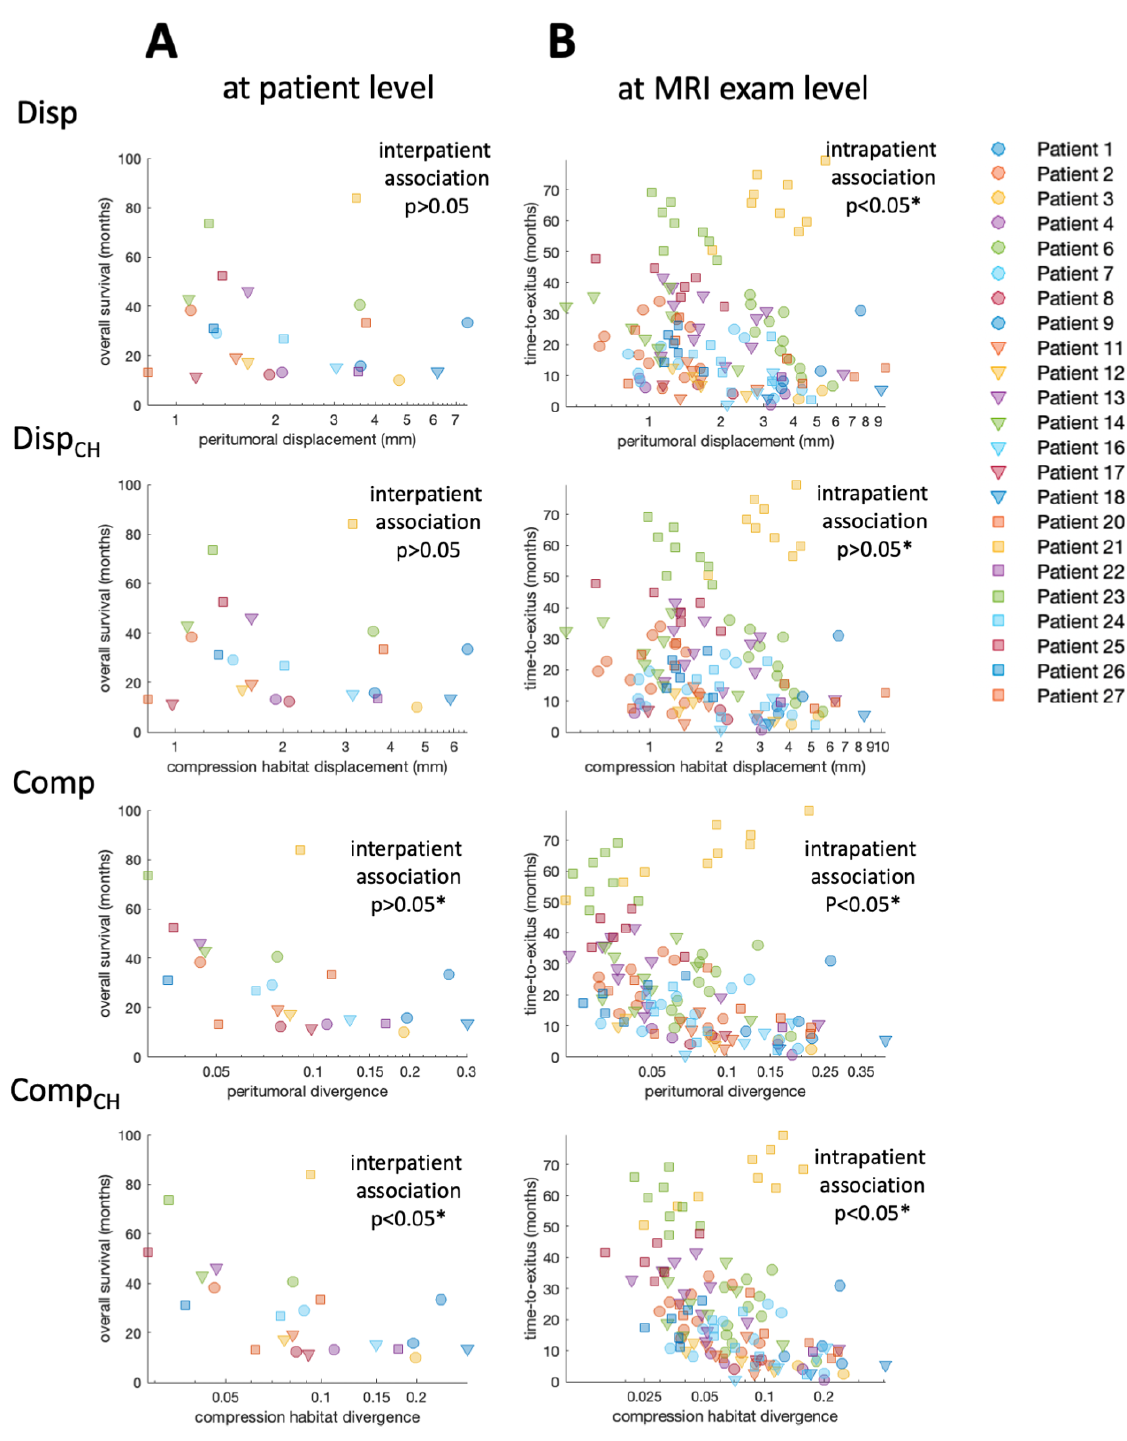
Figure 3. ( A ) Scatter plot showing the relation between median biomarker for each patient and overall survival. ( B ) Scatter plot showing the relation between biomarker for each MRI study and time-to-exitus. Each combination of marker color and shape corresponds to a different patient included in the study. * Indicates significant difference ( p < 0.05).